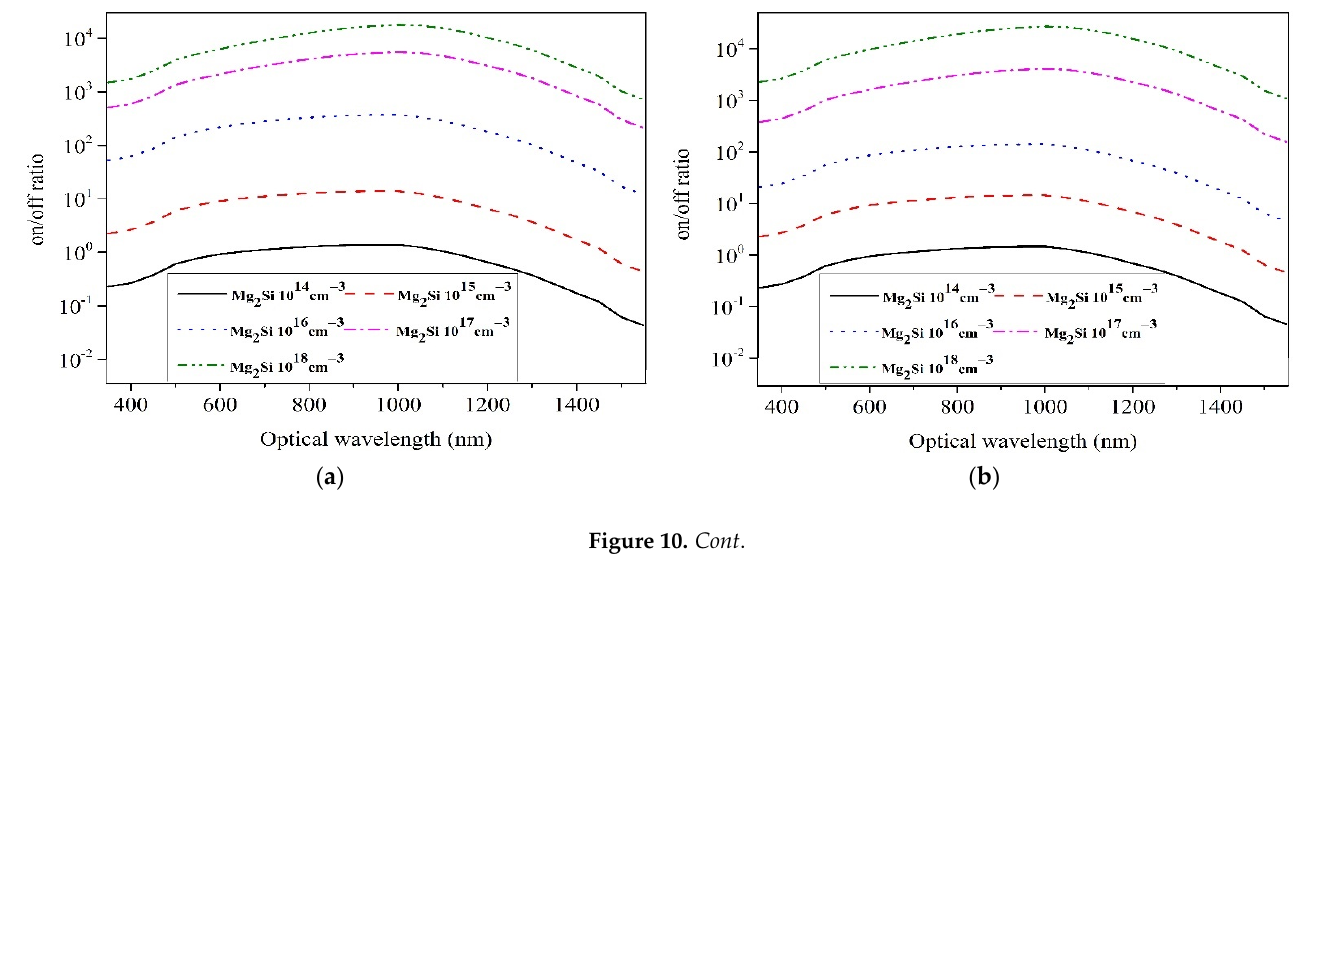
Figure 9. Detectivity curves of the heterojunction PDs with different doping concentrations. ( a ) Si–10 16 cm − 3 . ( b ) Si–10 17 cm − 3 . ( c ) Si–10 18 cm − 3 . ( d ) Si–10 19 cm − 3 . ( e ) Si–10 20 cm − 3 . ( f ) The effect of doping concentrations on detectivity.